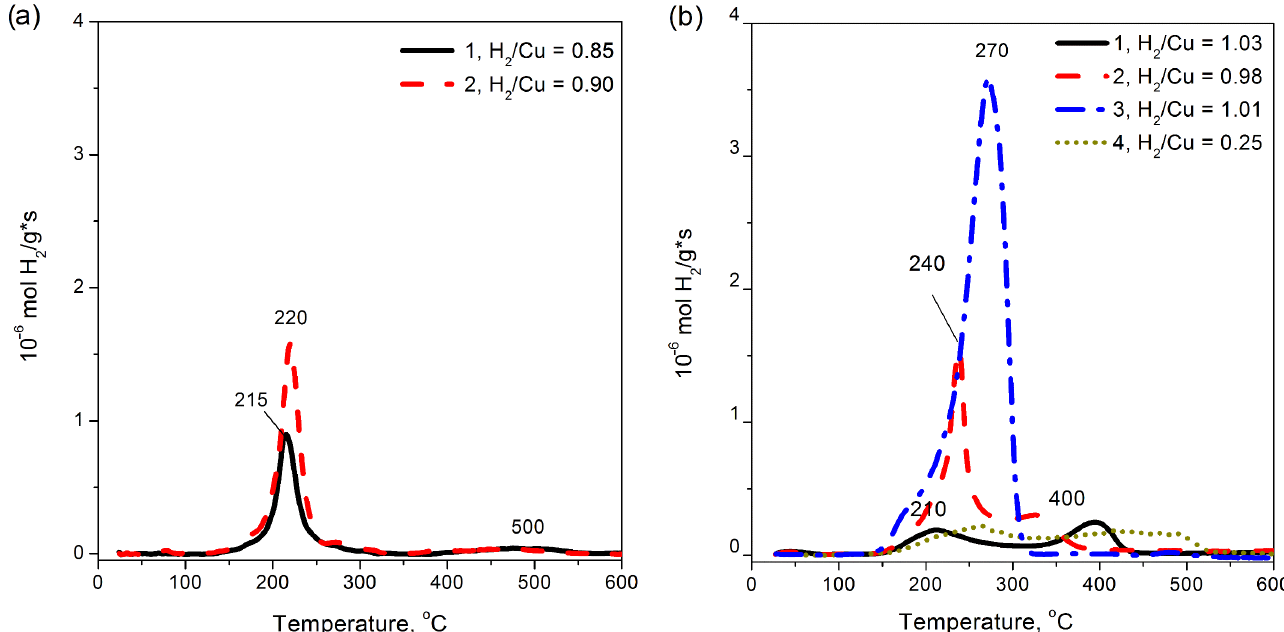
Figure 10. H 2 -TPR curves of Cu-containing MFI (a) and ZSM-5 (b) prepared by ion-exchange (1, 2, 3) and incipient wetness impregnation (4) after pretreatment in O 2 (1, 2, 3) or Ar (4) at 500 ° C. The samples are ( a ) 1.0%Cu-MFI-IEX (1), 2.0%Cu-MFI-IEX (2); ( b ) 1.0%Cu-ZSM-5-IEX (1), 2.8%Cu-ZSM-5-IEX (2 and 4), 16%Cu-ZSM-5-IMP (3).